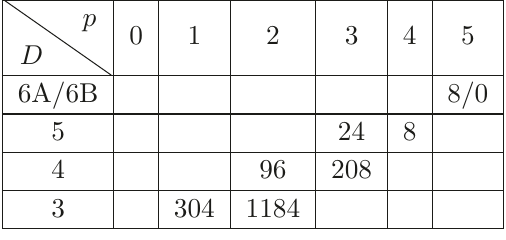
Table 12 . The F 9 , 3 family of branes for the ( T 4 / Z 2 ) × T n